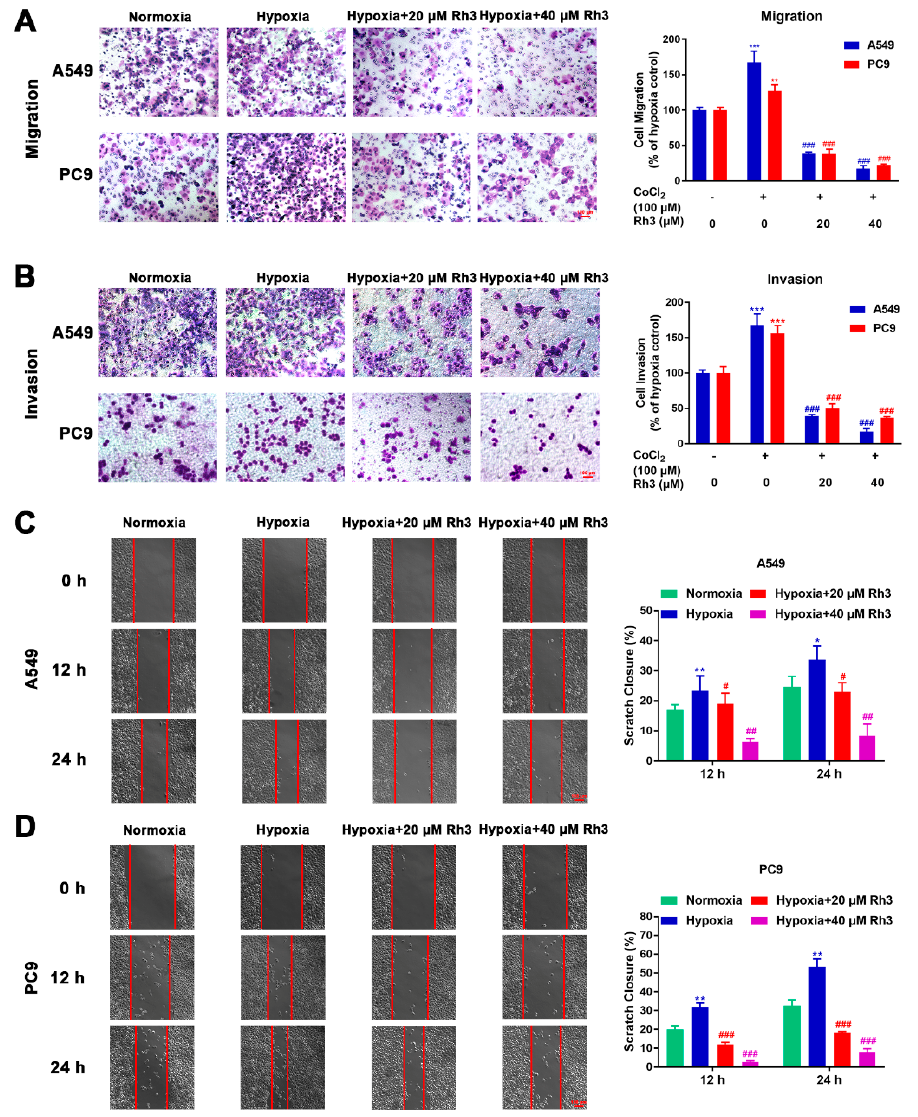
Figure 3. Rh3 inhibits the metastasis of lung cancer cells. The impact of Rh3 (20 and 40 μ M) on metastasis potential in A549 and PC9 cells as determined by Transwell assay ( A , B ) and wound- healing assay ( C , D ). Cells had been incubated under normoxia or hypoxia, induced by CoCl 2 , and treated with different doses of Rh3. Crystal violet was used to stain migrated and invaded cells in the Transwell assay; the data are expressed as percentages of CoCl 2 -treated cells. For the cell wound-healing assay, at 12 h and 24 h after scratching, the area of the wound area was assessed by microscopy at 100 × magnification. * p < 0.05, ** p < 0.01, *** p < 0.001 compared with the control. # p < 0.05, ## p < 0.01, ### p < 0.001 compared with control cells treated with CoCl 2